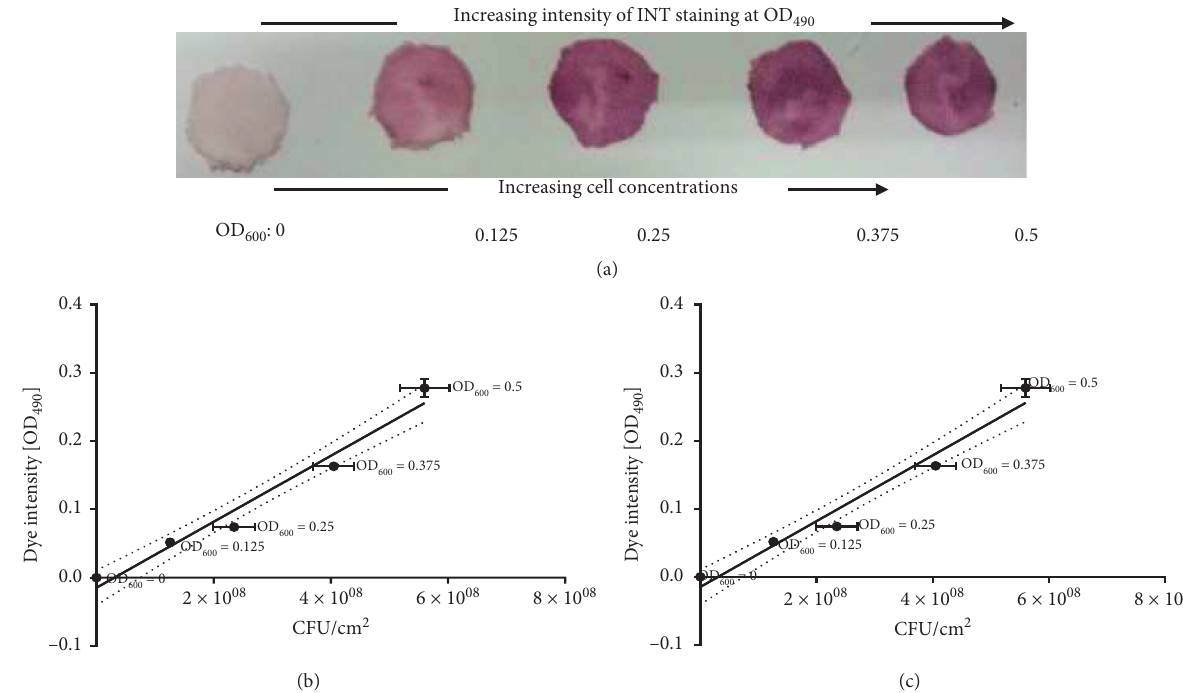
Figure 9: Standard curves of the INTstaining intensity relative to the cell numbers. Solutions containing different numbers of C. krusei cells were applied onto Mendy fabric and stained with INTfor 30minutes (a). Bacteria/fungi CFU/cm 2 ( x -axis) are correlated to the intensity of INTstaining at OD 490 ( y -axis). Initial OD 600 of the applied fungal/bacterial solution is indicated for each data point. By applying a volume of 100 µ L, C. krusei with an initial OD 600 of 0.5 was found to correspond to 5.6 × 10 8 fungal cells per cm 2 of fabric after 1hour incubation (b), while an OD 600 of 0.5 equaled 3.15 × 10 10 M. smegmatis cells per cm 2 (c). A linear regression (black line) through the background value precisely fits the staining intensity quantified for different cell numbers, indicating that there is no saturation of dye production in the tested cell densities. Error bars represent measurements for 4 individual fabric